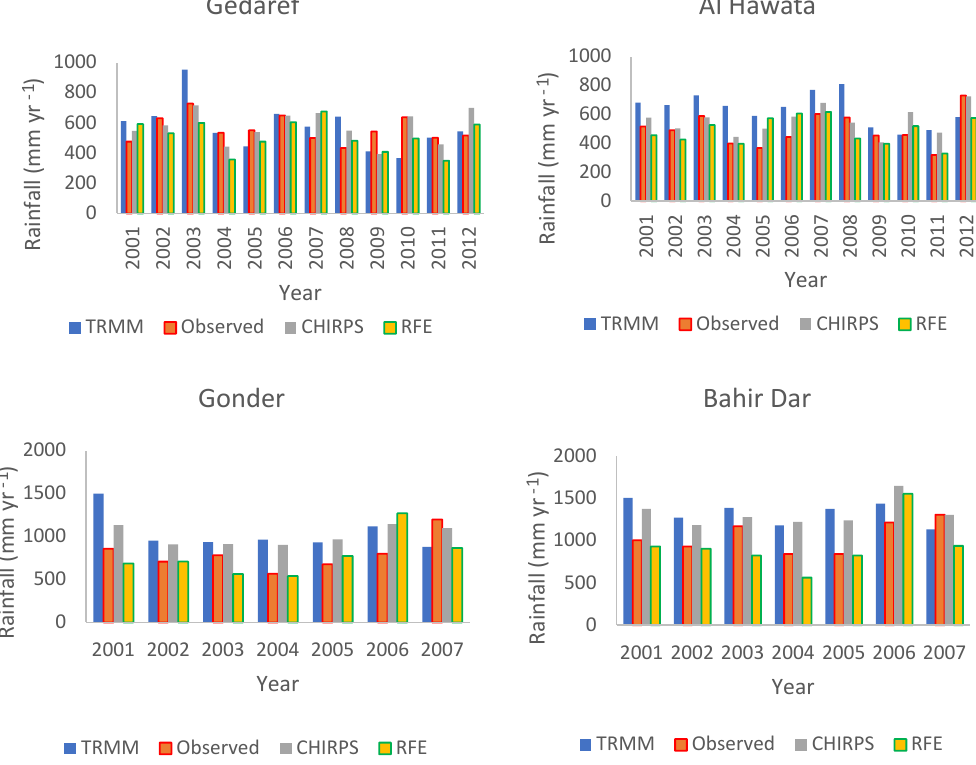
Figure 5. Comparison of SBRE products with ground measurements at four